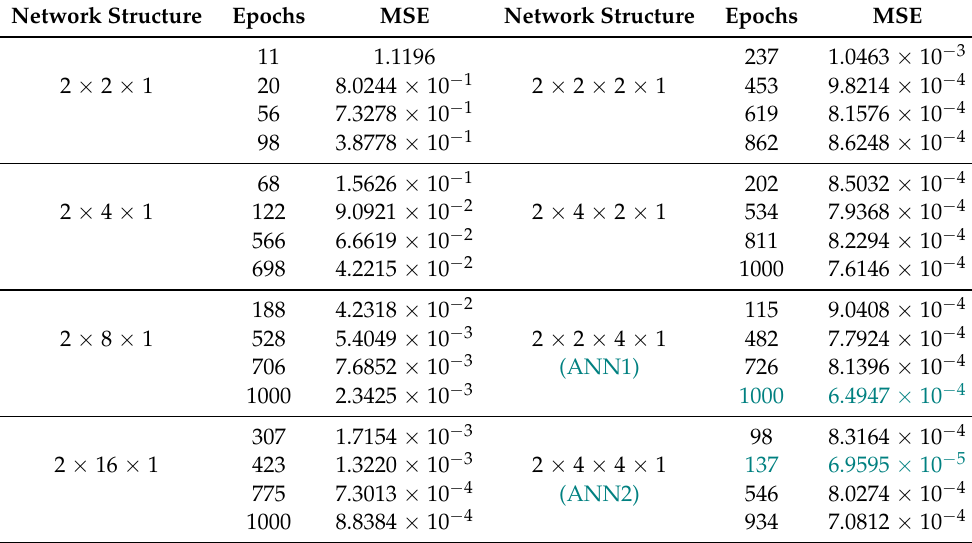
Table 2. Training performance of different structures using the Levenberg–Marquardt algorithm.